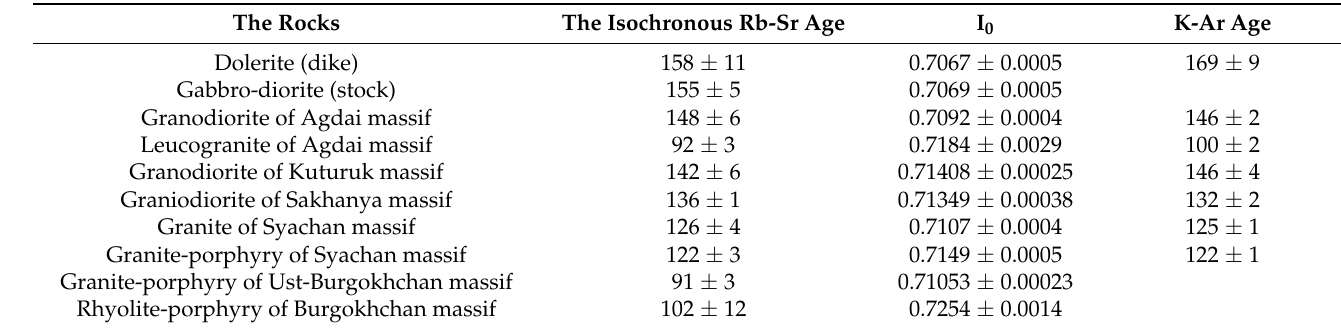
Table 1. The isochronous age of magmatic rocks.